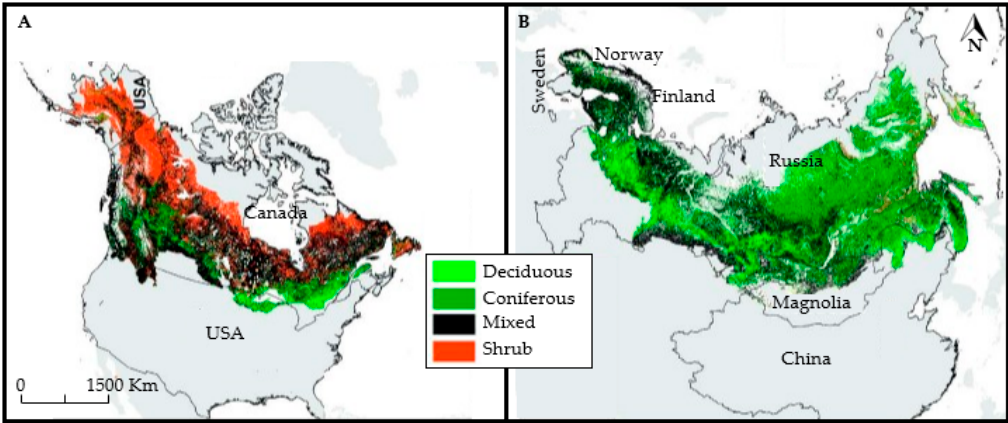
Figure 1. Global extent of the boreal circumpolar forest (( A ): North American and ( B ): Eurasian) and major vegetative cover according to the 2000 Global Landcover dataset (www-tem.jrc.it / glc2000 / ) and modified after Bradshaw et al. [35].